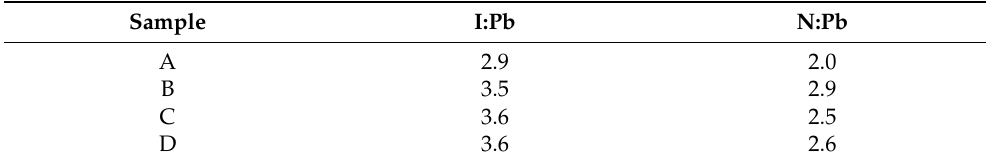
Table 2. Lead-based atomic ratios for iodine and nitrogen in perovskite films considered in spectral analyses.